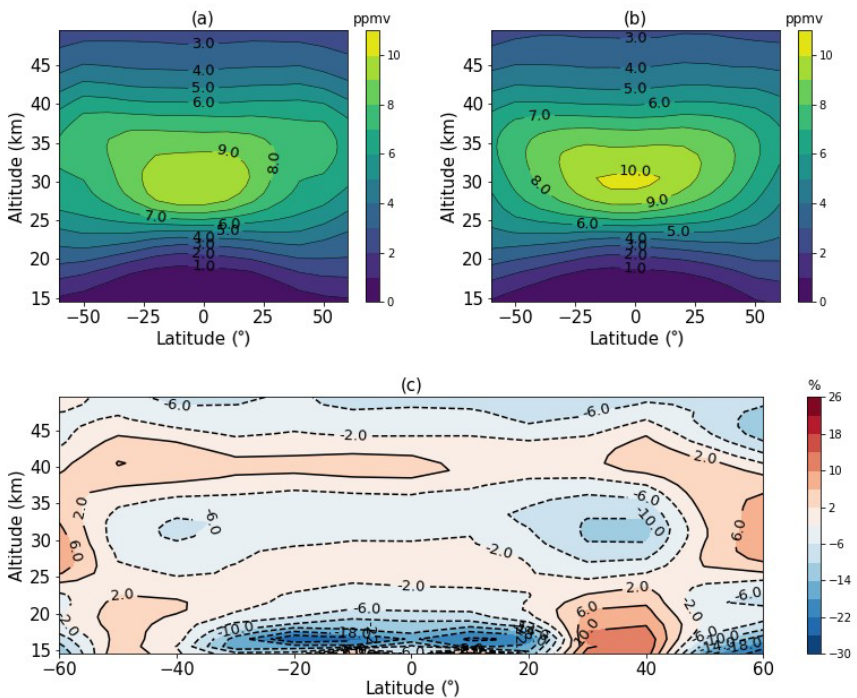
Figure 9. Zonal mean ozone comparisons between SAGE III-ISS and ACE-FTS between 15 and 50km. (a) The zonal mean ozone for SAGE III-ISS. (b) The zonal mean ozone for ACE-FTS. (c) The zonal mean ozone percentage difference between the two abovementioned instruments.